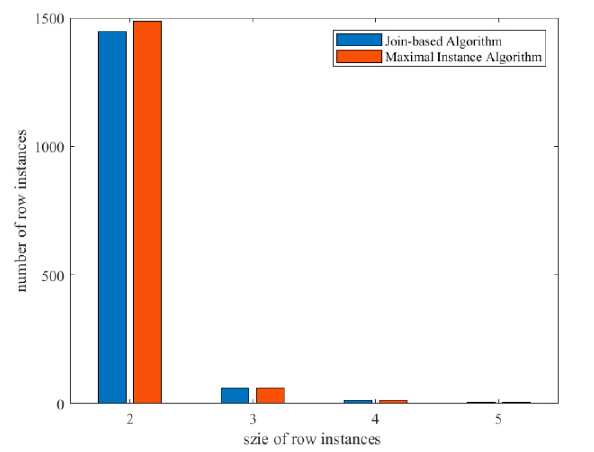
Figure 7. Comparison of row instances generated by the join-based algorithm a and the maximal instance algorithm.